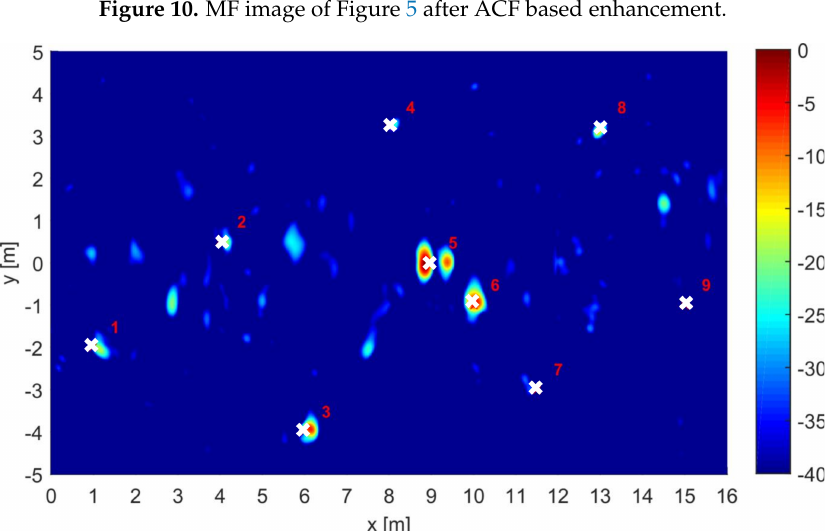
Figure 11. BP image of Figure 7 after ACF based